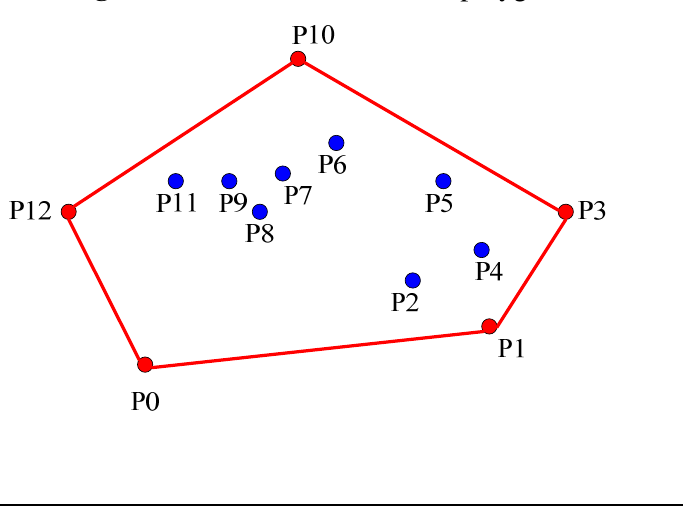
Figure 3. The minimum convex polygon.